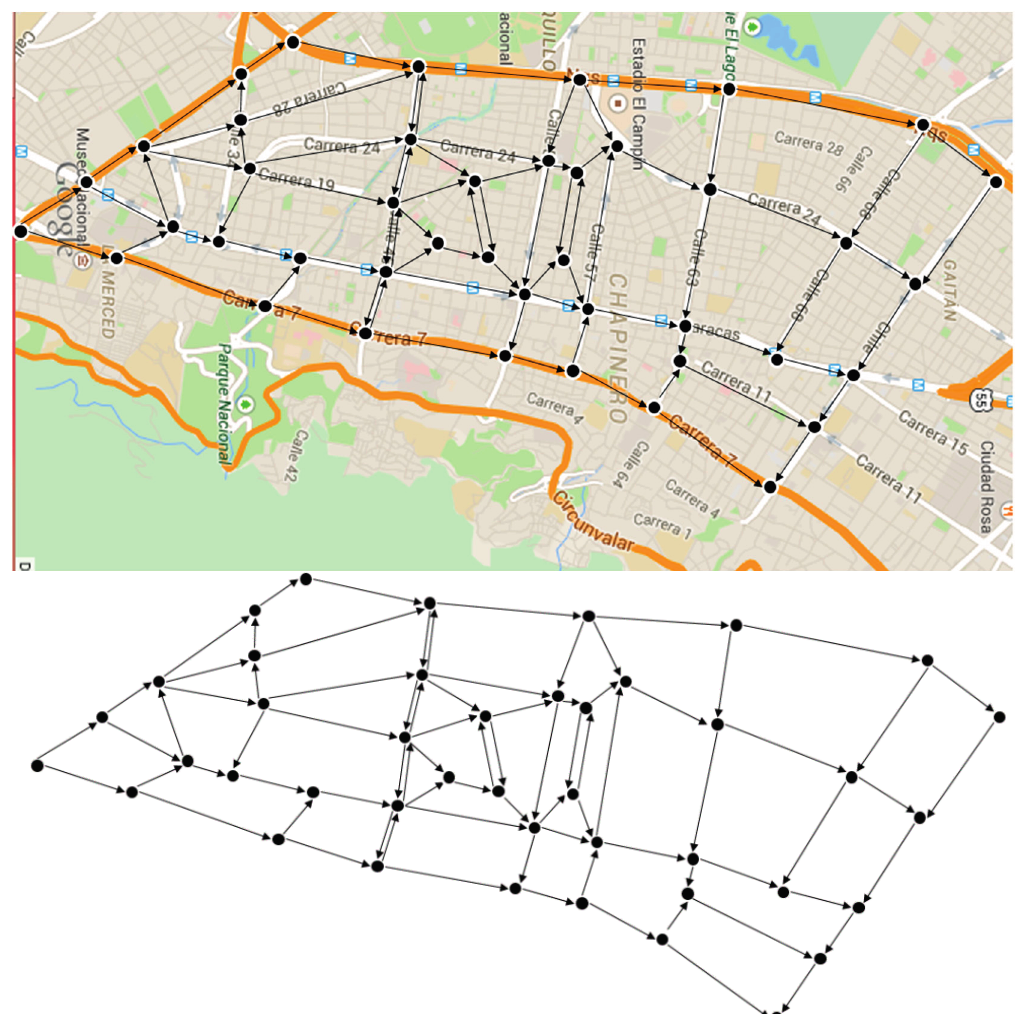
Figure 18. Proposed vehicular